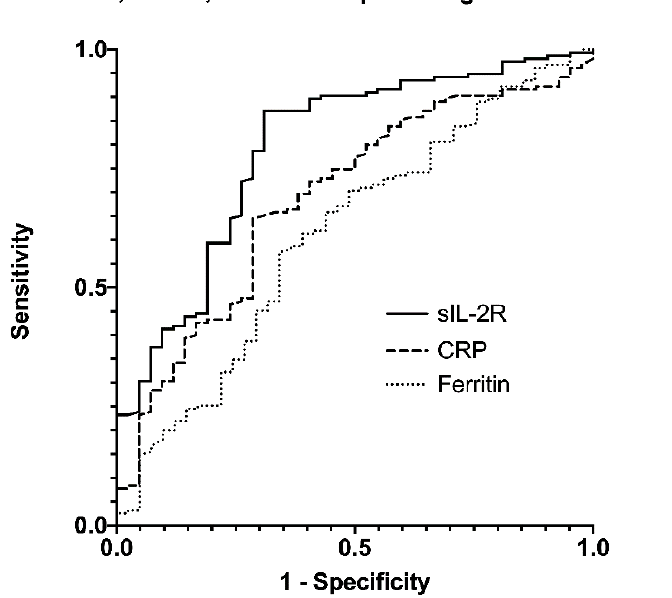
Figure 1. Receiver operating characteristic curves for the prediction of intubation or death according to sIL-2R, ferritin and CRP. sIL-2R had the highest diagnostic accuracy for intubation/death (AUC (95% CI): 0.789 (0.709–0.869)), compared with ferritin (AUC (95%CI): 0.612 (0.513–0.711); p = 0.004) and CRP (AUC (95%CI): 0.683 (0.594–0.773); p = 0.065). sIL-2R: soluble interleukin-2 receptor; CRP: C-reactive protein; AUC: area under the curve. Youden’s index revealed an optimal cut-off of sIL-2R for predicting intubation or death at 9 ng/mL with sensitivity of 67% and specificity of 86% (PPV: 86%, NPV: 91%). Patients with sIL-2R ≥ 9 ng/mL were characterised by increased age ( p < 0.001), lower Total ( n = pO2/FiO2 ratio ( p < 0.001), increased respiratory rate ( p = 0.008), lower lymphocytes ( p = 0.007) and higher CRP levels ( p = 0.003; Table 3). Table 3. Baseline factors associated with increased sIL-2R levels ( ≥ 9 ng/mL).